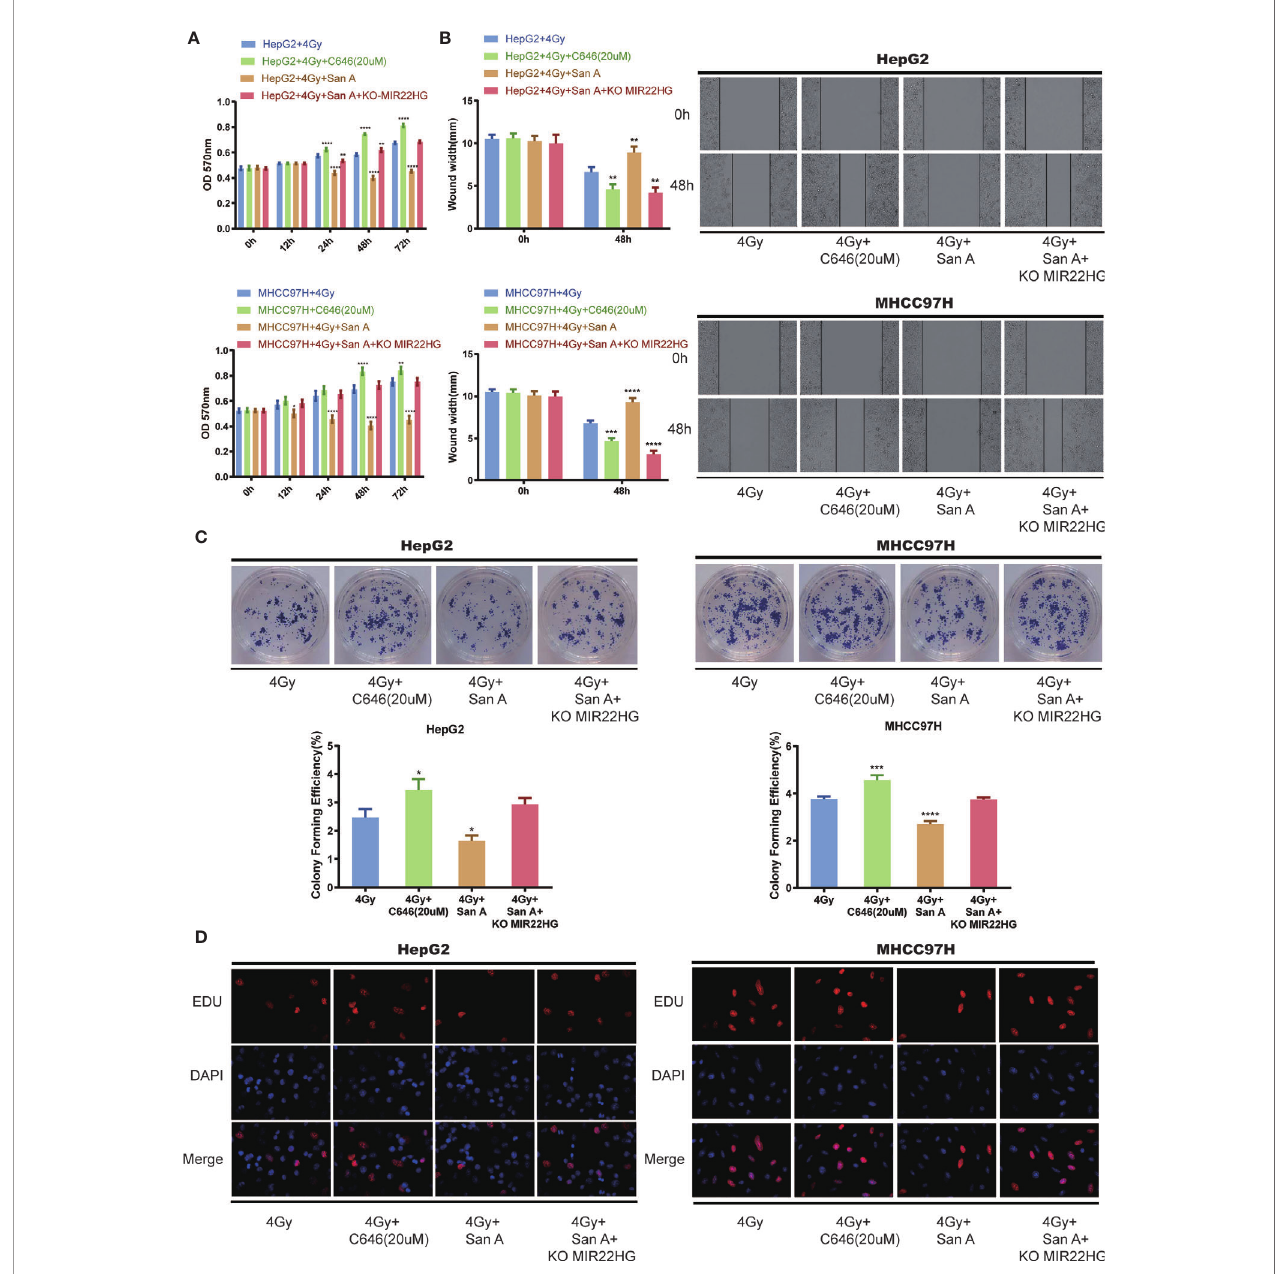
FIGURE 4 | (A) MTT assay showing the cell proliferation of HepG2 and MHCC97H cells with different treatments. *Compared with HepG2 + 4 Gy and MHCC97H + 4 Gy groups. (B) Wound healing assay showing the migration of HepG2 and MHCC97H cells with different treatments. *Compared with HepG2 + 4 Gy and MHCC97H + 4 Gy groups. (C) Colony formation of HepG2 and MHCC97H cells with different treatments. *Compared with HepG2 + 4 Gy and MHCC97H + 4 Gy groups. (D) EdU assay showing the cell proliferation of HepG2 and MHCC97H cells with different treatments. Mean ± SD (n = 3 independent experiments). * p < 0.05, ** p < 0.01, *** p < 0.001, **** p < 0.0001. San A, Santacruzamate A; KO MIR22HG, knockout